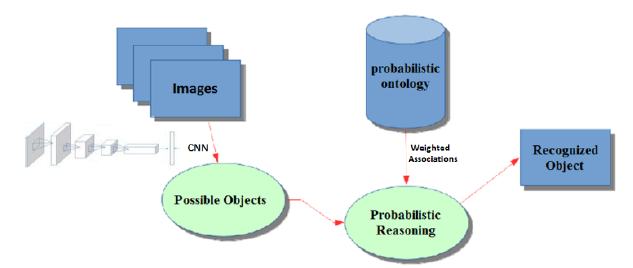
Figure 7 . First level of classification recognizes both objects as towers.